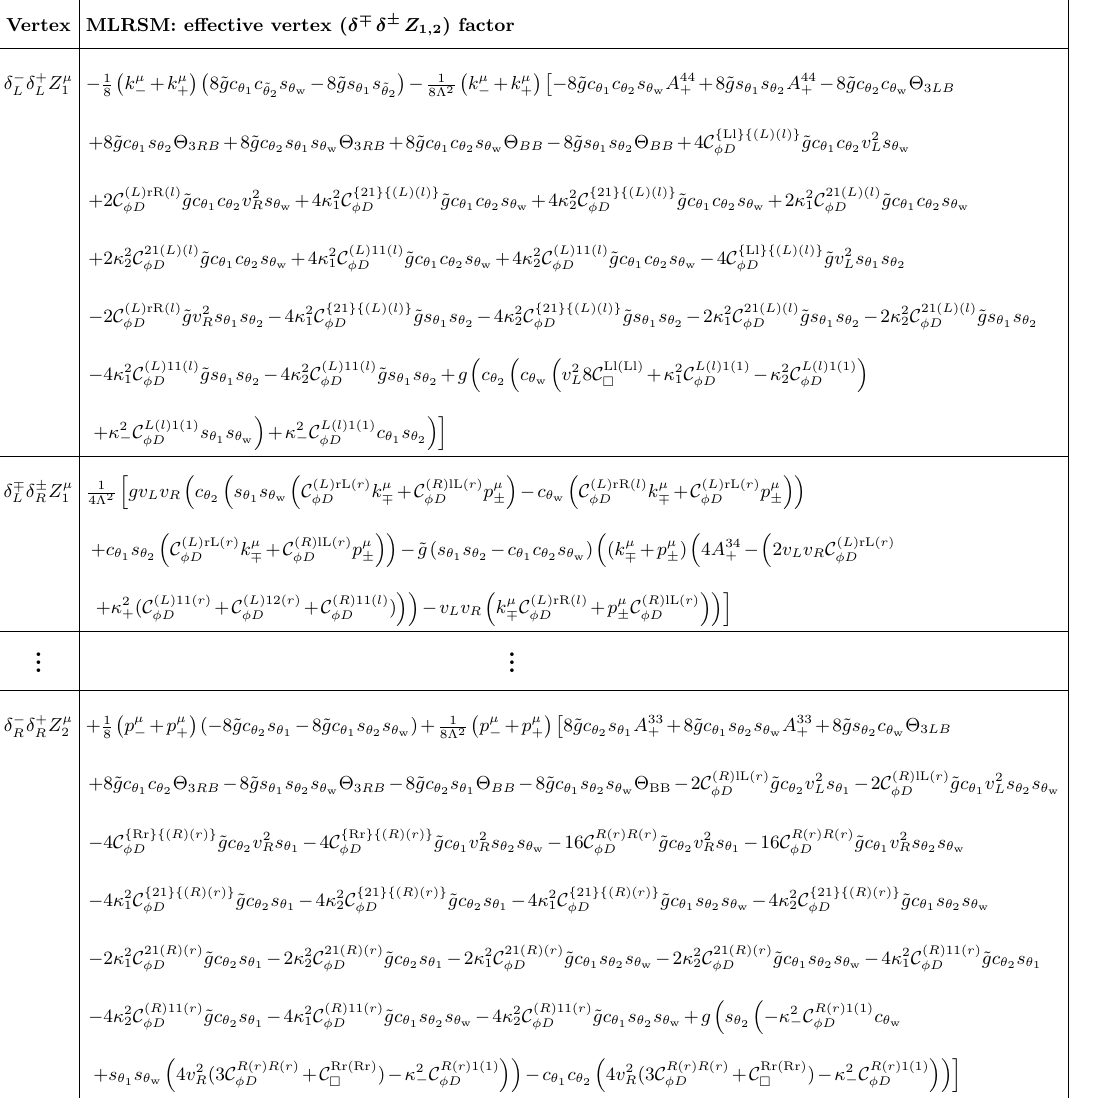
Table 45. MLRSM: coupling of a pair of singly charged scalars ( (cid:14) (cid:6) ) with a neutral gauge boson ( Z 1 ; 2 ). Here s (cid:18) = sin (cid:18) i and c (cid:18) = cos (cid:18) i . k (cid:22) and p (cid:22) are the four momenta of (cid:14) (cid:6) (cid:6) (cid:6) i i rede(cid:12)ned angle de(cid:12)ned in eq. (6.102) .